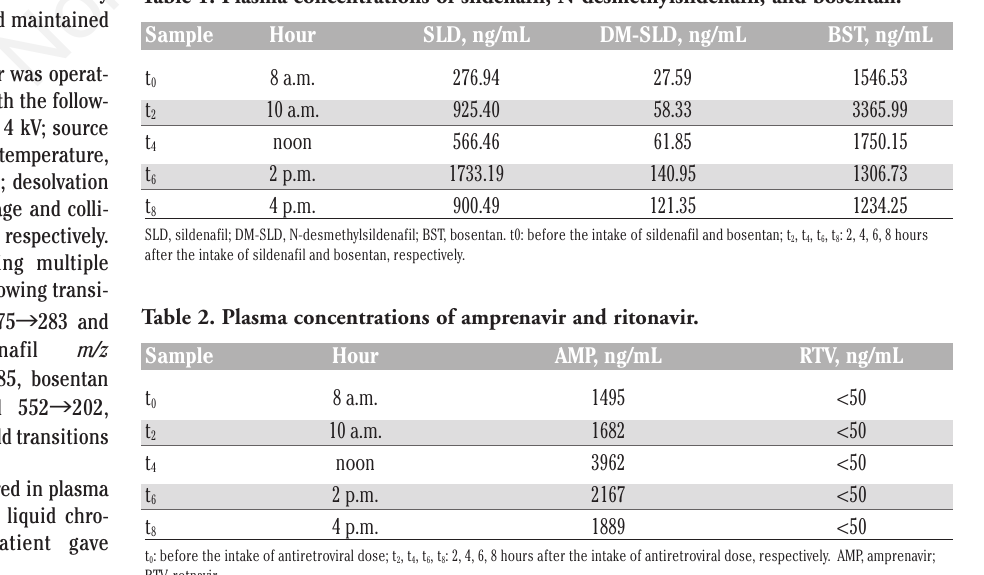
Table 1. Plasma concentrations of sildenafil, N-desmethylsildenafil, and bosentan.